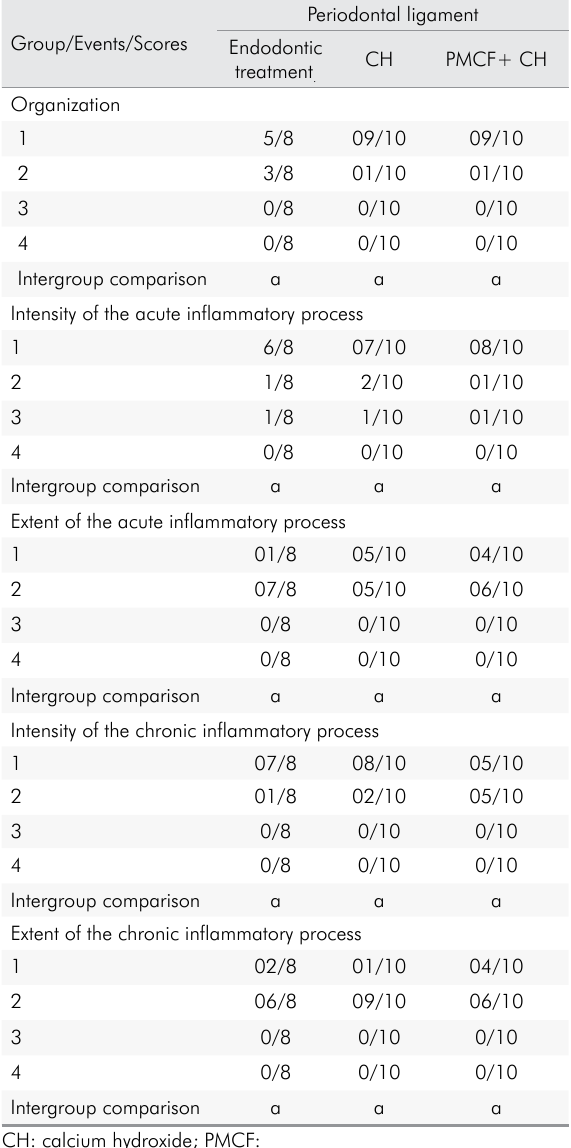
Table 5. Distribution of scores and statistical analysis of the histomorphometric events associated with bone tissue (Wilcoxon Signed Ranks Test at 5% significance